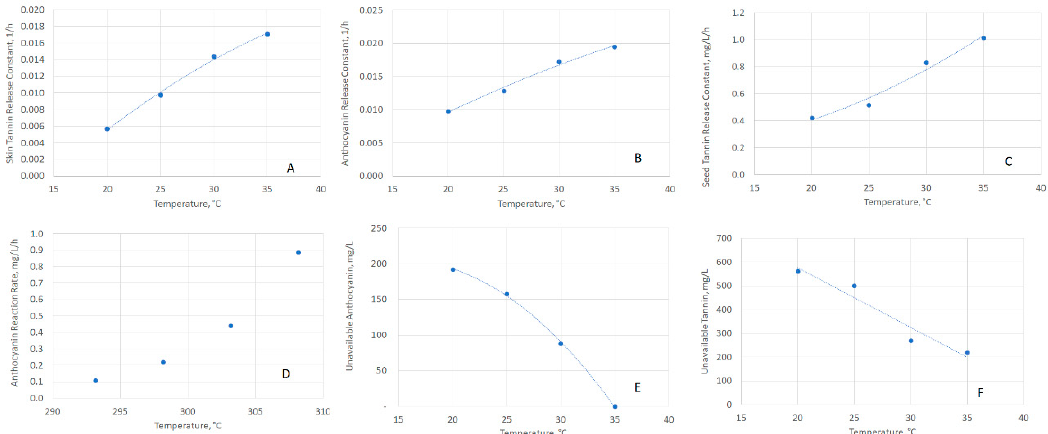
Table 1. Activation Energies for Anthocyanin Degradation.